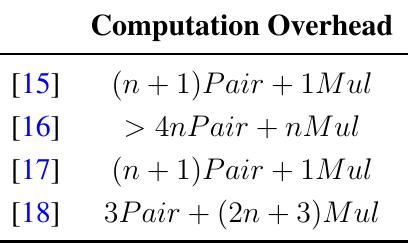
Table 2. The computational overhead for repeating